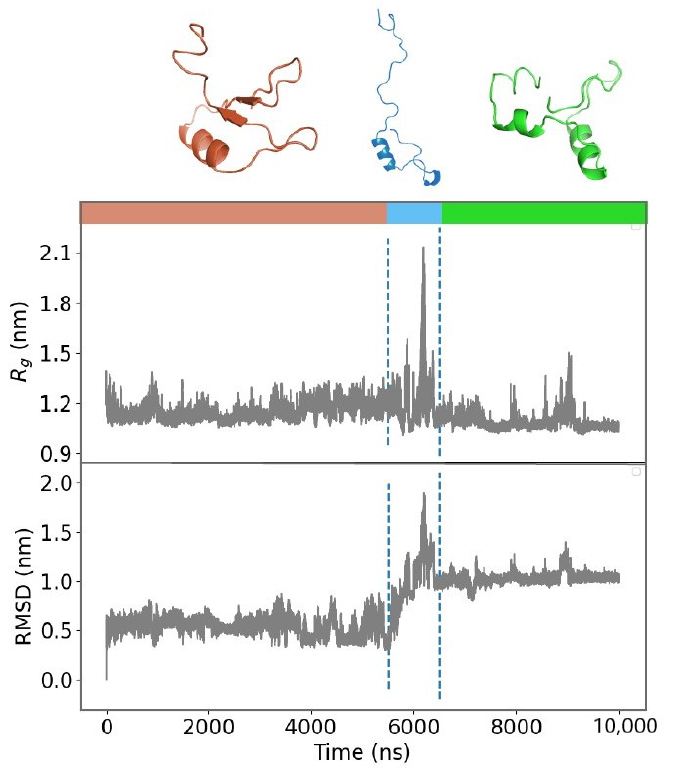
Figure 3. Analysis of the unfolding process of Fragment B. Time evolution of the Radius of Gyration ( R g ) and Root Mean Square Deviation (RMSD) for Fragment B. The time span is divided into three parts (marked by the dotted lines at approximately 5.5 and 6.5 µ s), according to the different overall organization displayed by the fragment during the dynamics. Representative cartoon representations of the fragment structure are reported on the upper side of the